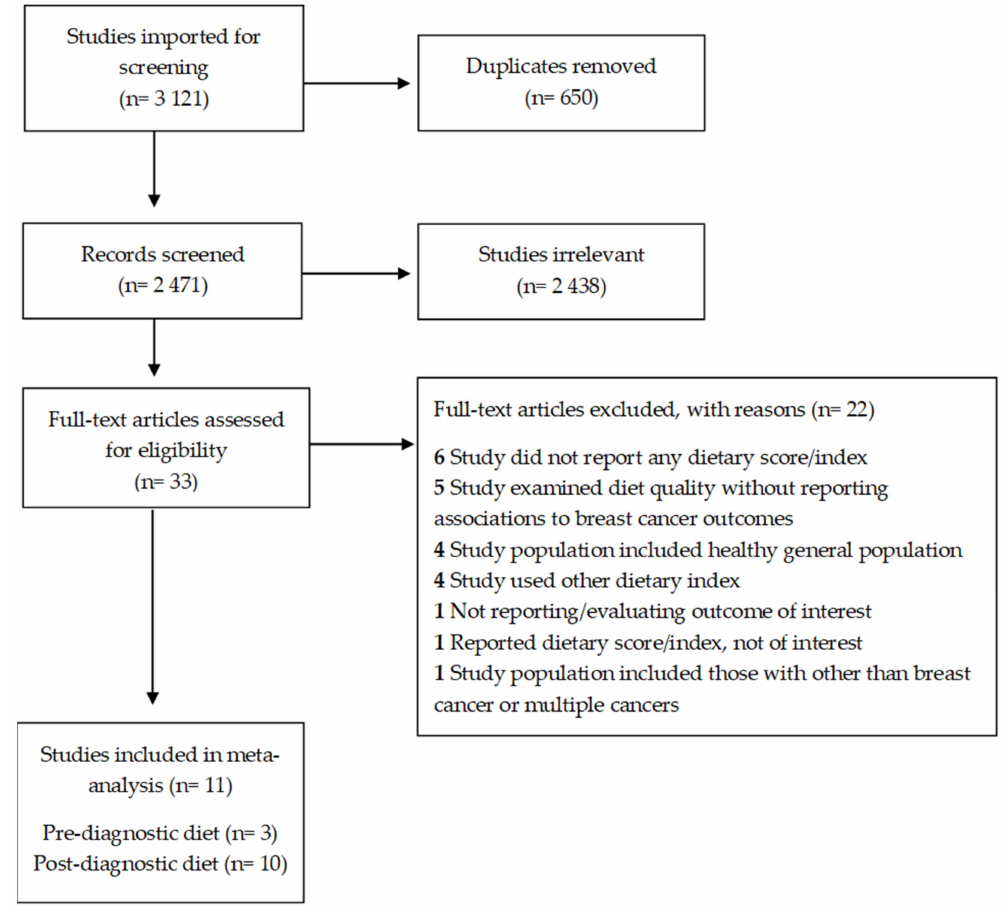
Figure 1. Preferred reporting items for systematic reviews and meta-analyses (PRISMA) flow